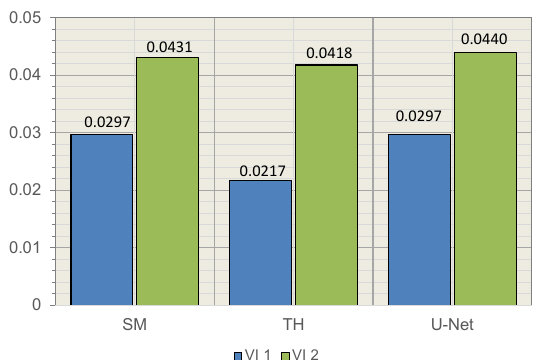
Figure 10. Comparing calculated void fraction between different